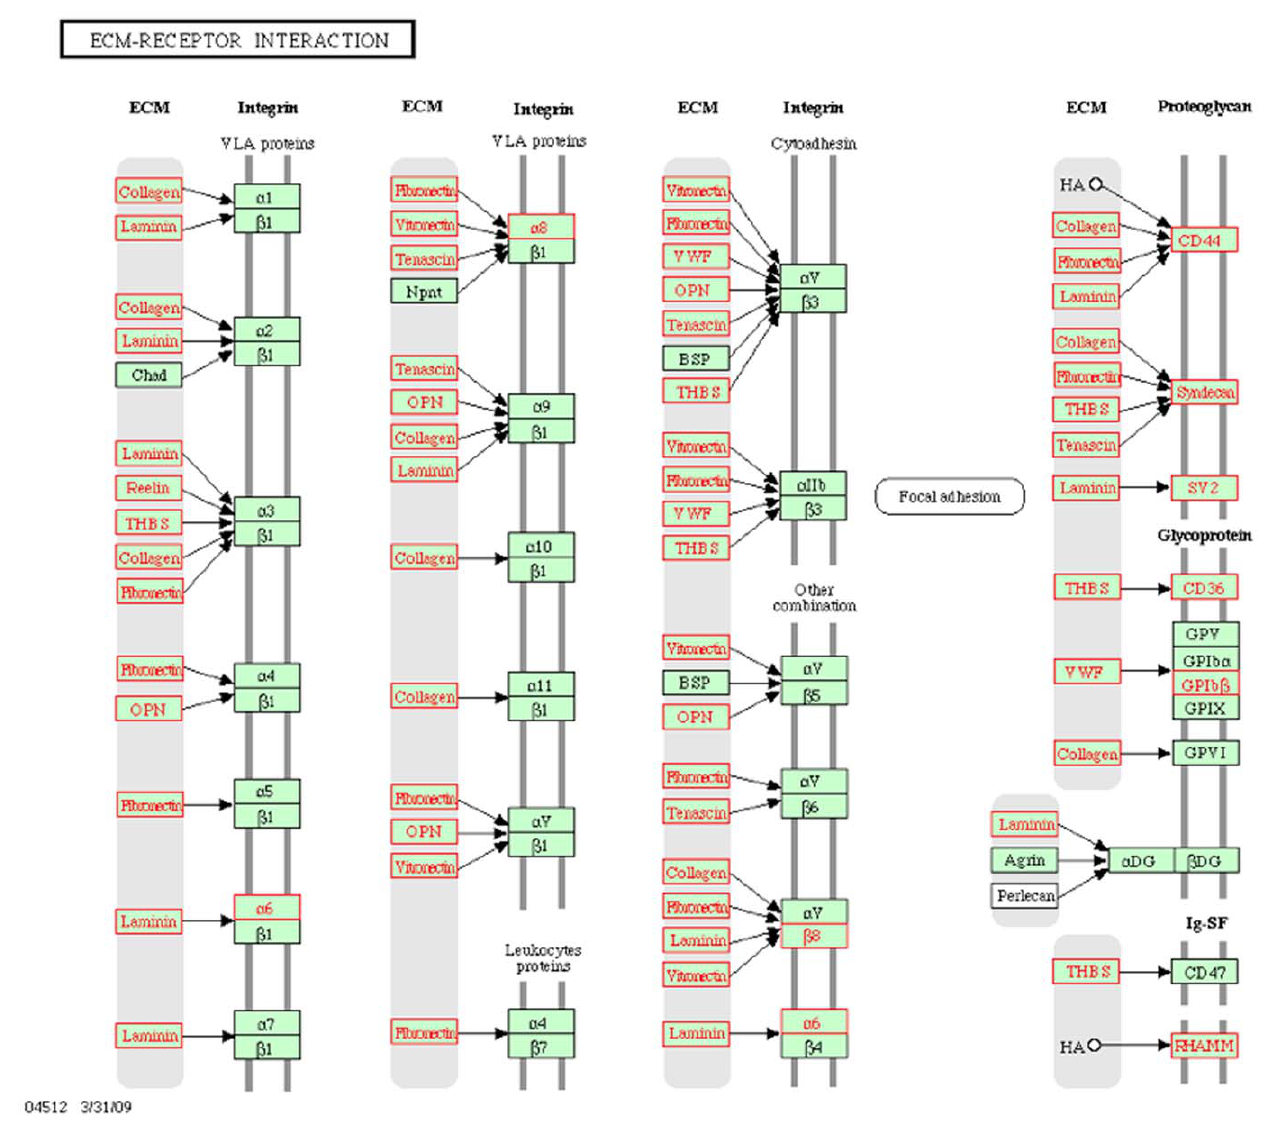
Figure 5. Switch-like genes highlighted in the KEGG ‘‘ECM-receptor interaction’’ diagram. Nodes representing switch-like genes are outlined in